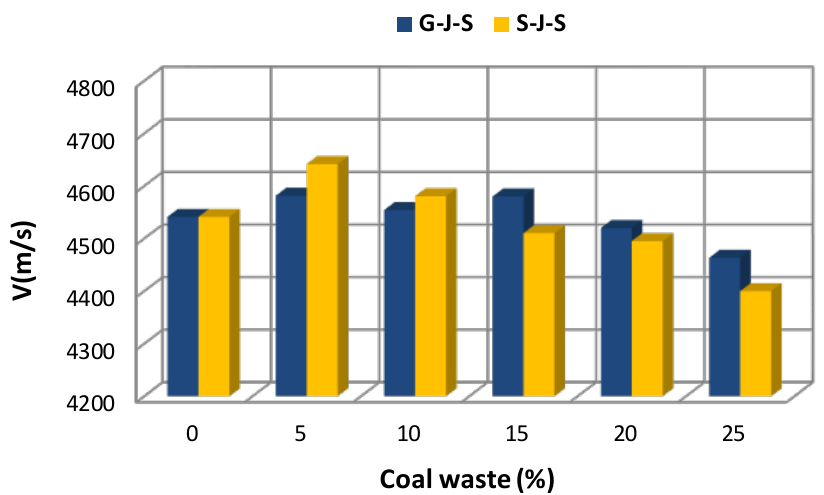
Figure 6. Effect of replacing aggregates with coal waste at the age of 14 days .